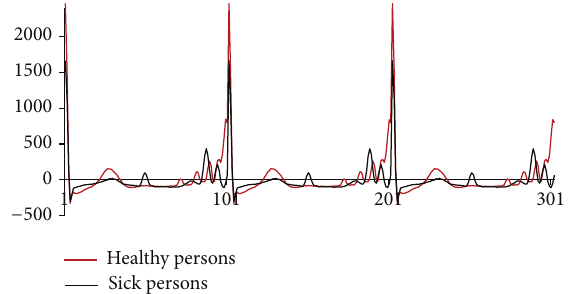
Figure 4: Comparison of mean values of ECG waveforms for healthy/sick